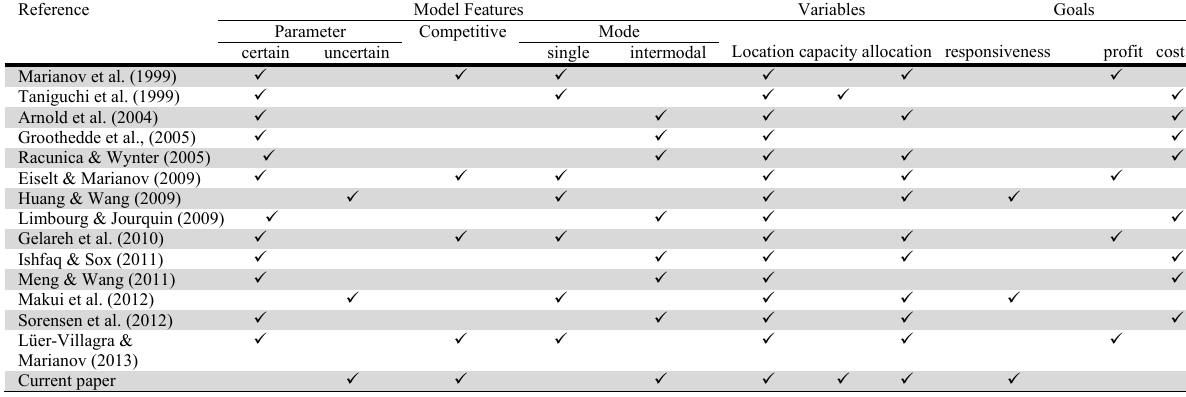
Table 1 Comparison of current paper’s and related studies’ capabilities